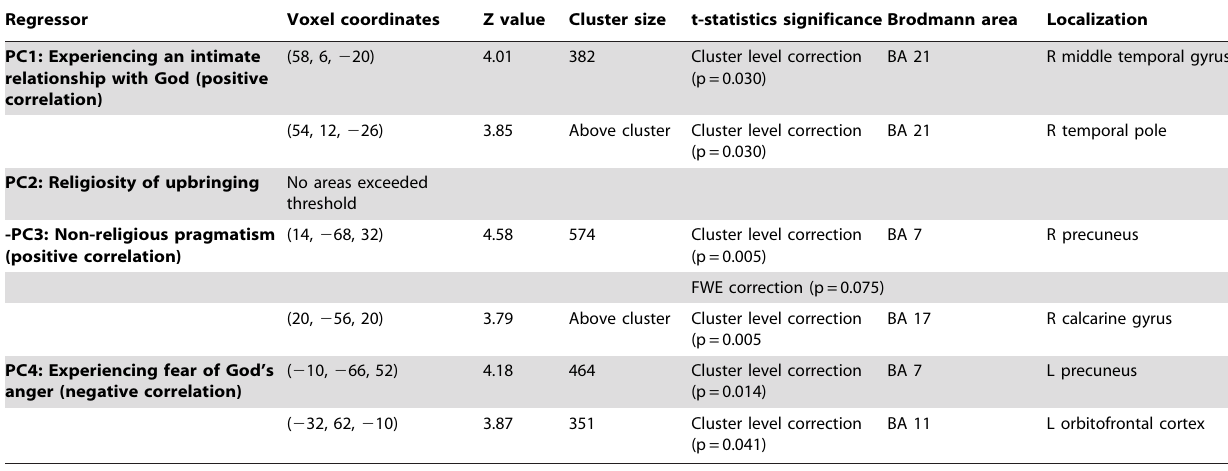
Table 2. Cortical areas whose volume is associated with the PCs.